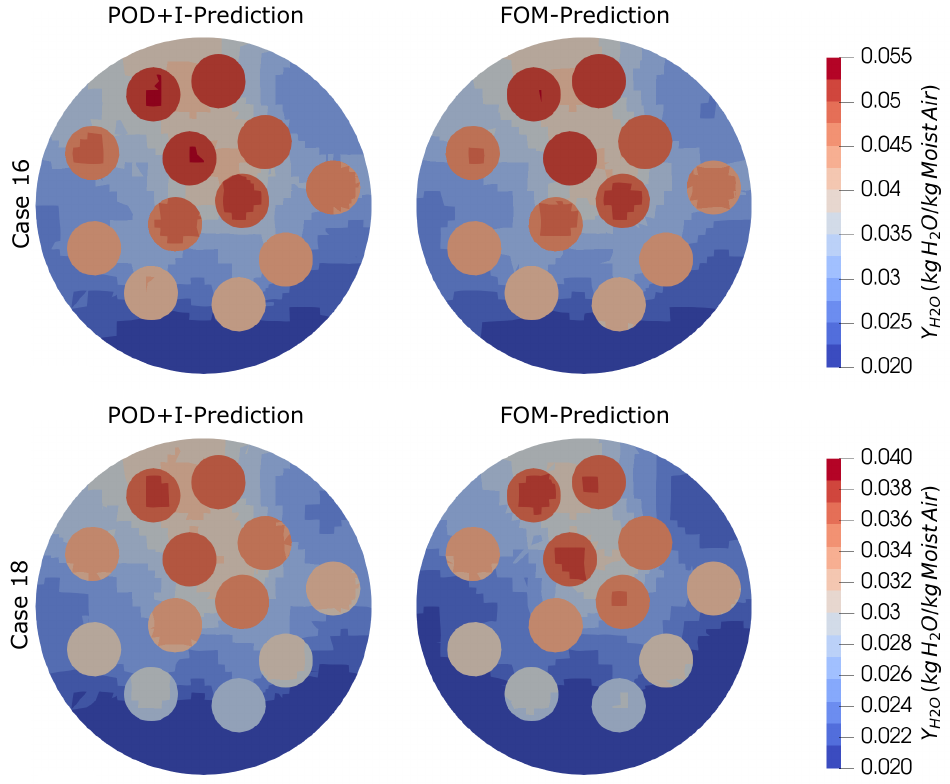
Figure 10. Comparison of the water mass fraction contours calculated by evaluating the FOM and surrogate model for cases 16 and 18 in Table A1. The surrogate model was calculated based on the Halton sequence sampling. The colour bars for case 16 and 18 do not